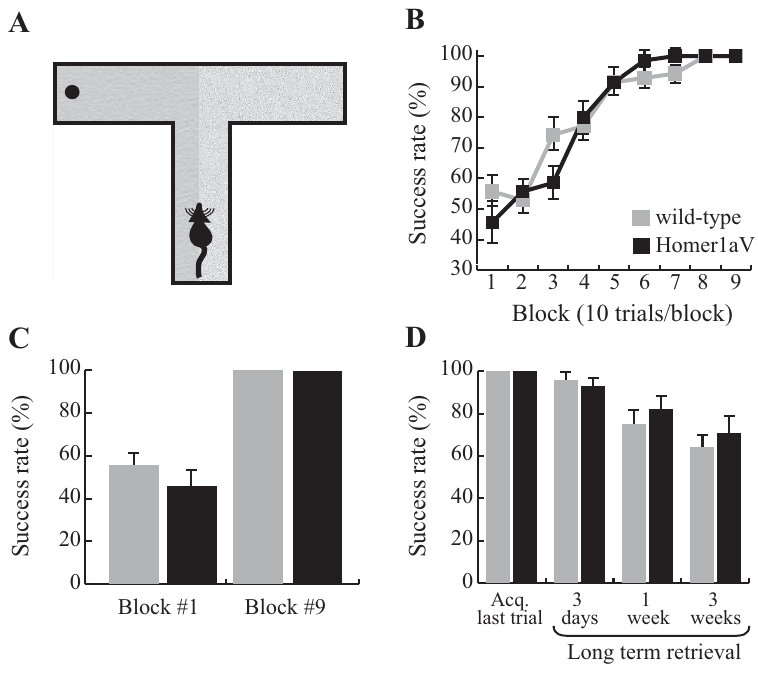
Figure 8. Intact long-term memory during sustained H1aV expression . ( A ) Mice were trained on a tactile spatial reference memory task to associate the location of the food reward with one of the two sandpaper samples, before being tested in the long-term retention phase of the experiment. ( B ) Both wild-type (N=7)andTgH1aV.Fbmice(N=7)learnedthetaskinlessthan60trialsatanasymptoticperformancelevel.( C )Theoverallsuccesslevelacrosstheexperimental groups was not different at the start (block #1) and end (block #9) of the training. ( D ) After all mice reached 100% success rate, they were retested 3 days, 1 week, or 3 weeks after the end of the acquisition phase of the training. Neither group significantly differed from each other at any time point.